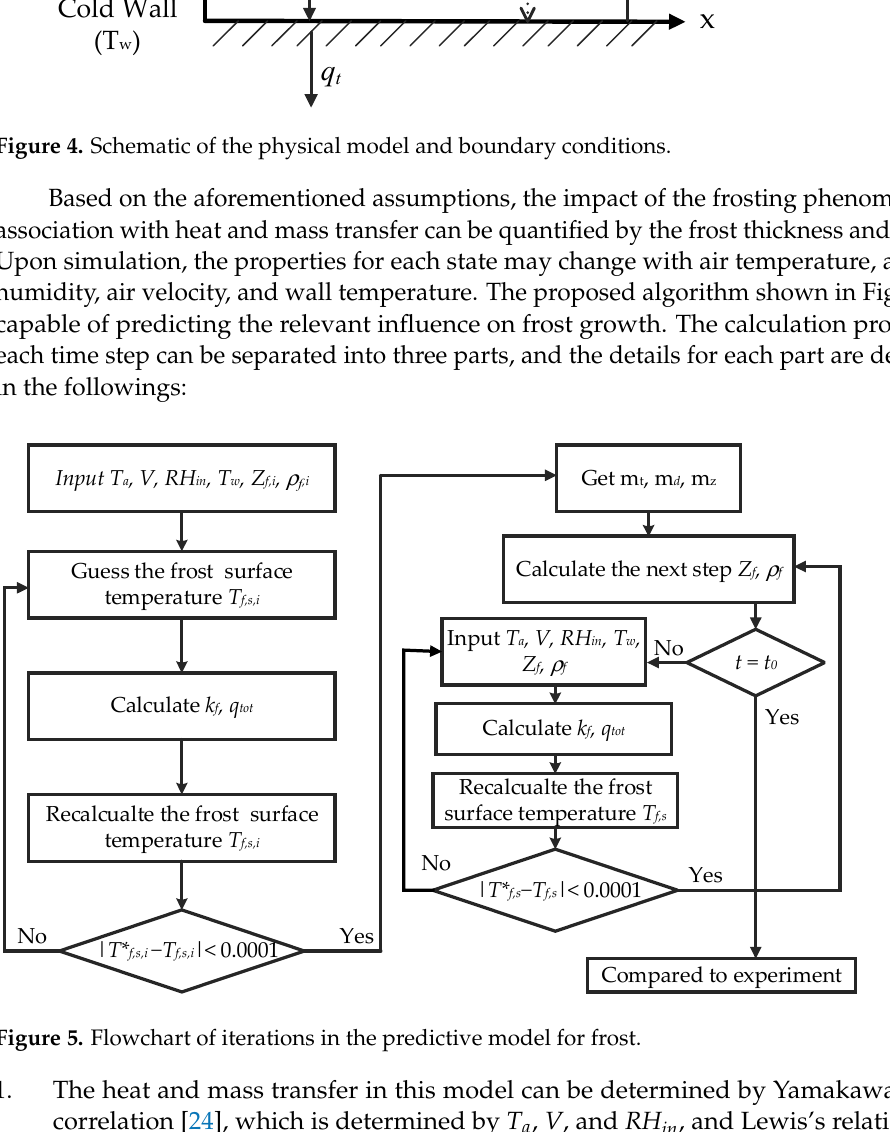
The properties of air in this model are obtained by the NIST REFPROP program [25].